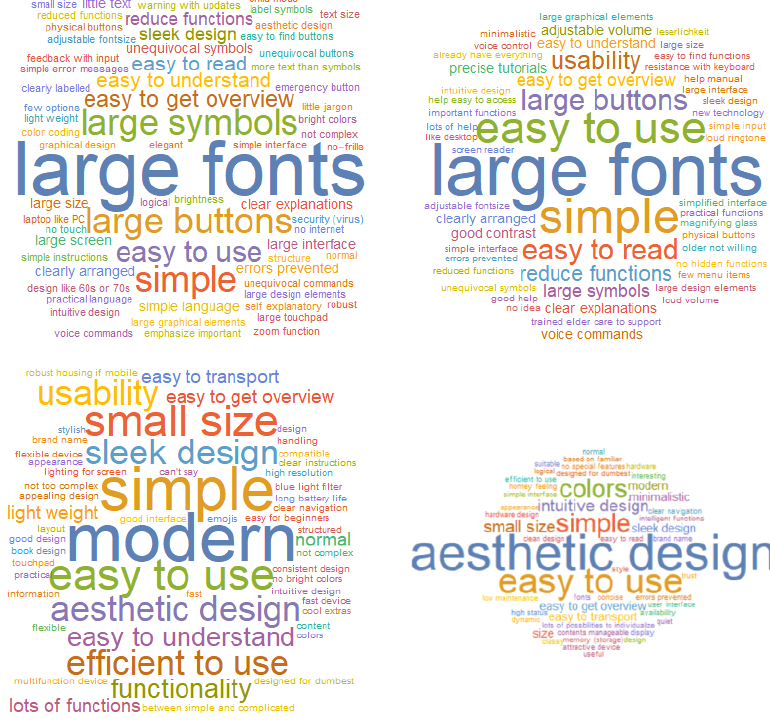
Figure 4. Design aspects mentioned: for older men ( top left ); older women ( top right ); younger men ( lower left ); and younger women ( lower right